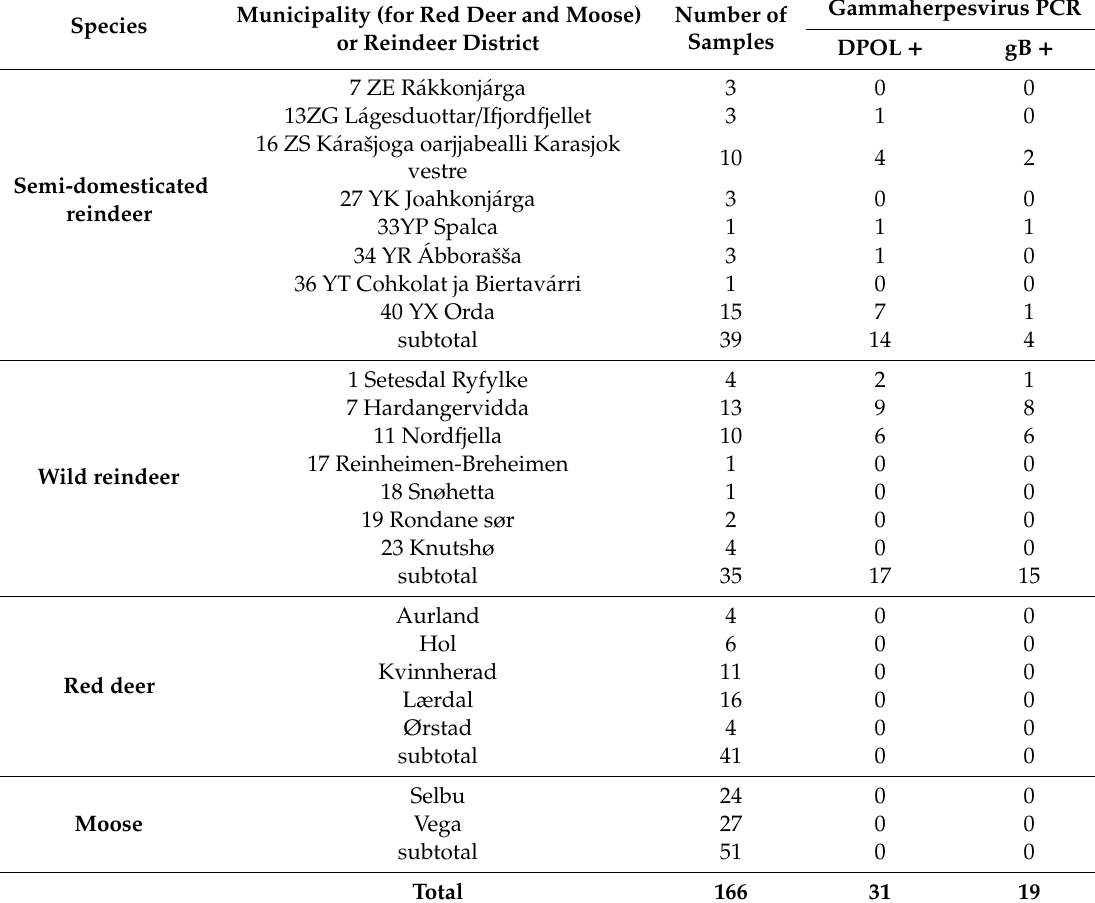
Table 1. Results for the gammaherpesvirus PCRs conducted in this study presented by species, and district / municipality of origin (wild cervids) or reindeer-herding district in Finnmark County (semi-domestic